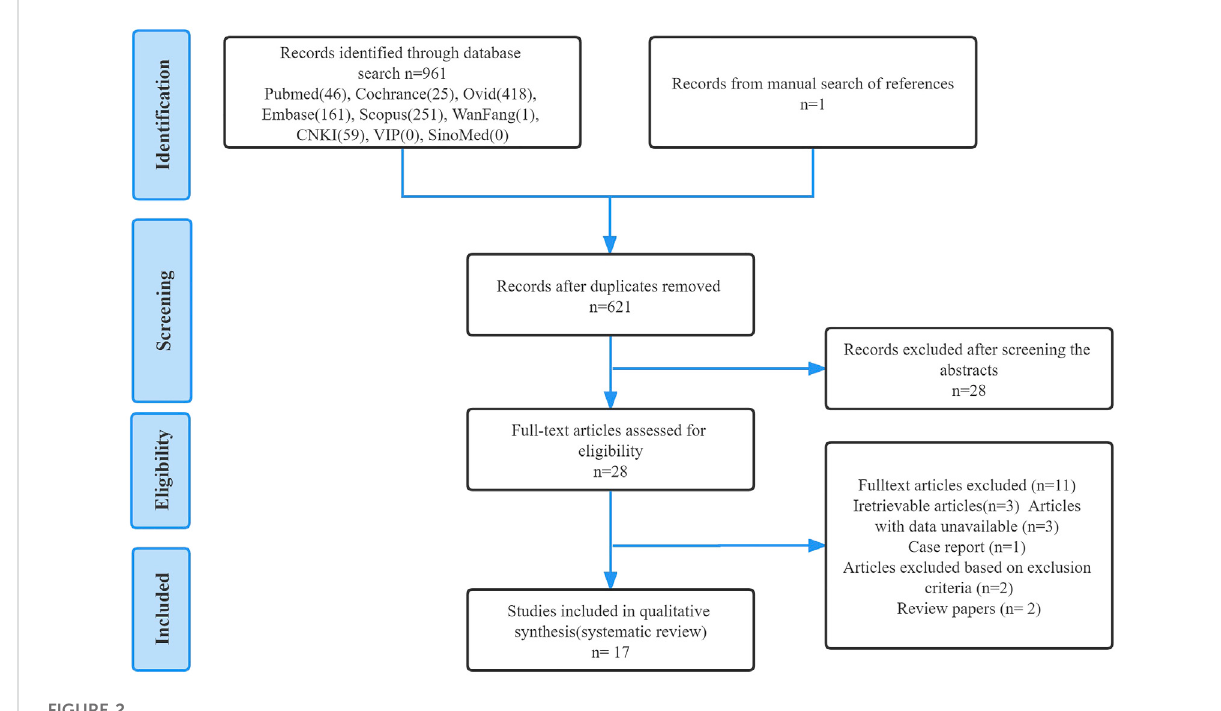
FIGURE 2 PRISMA fl ow diagram presenting the detailed search